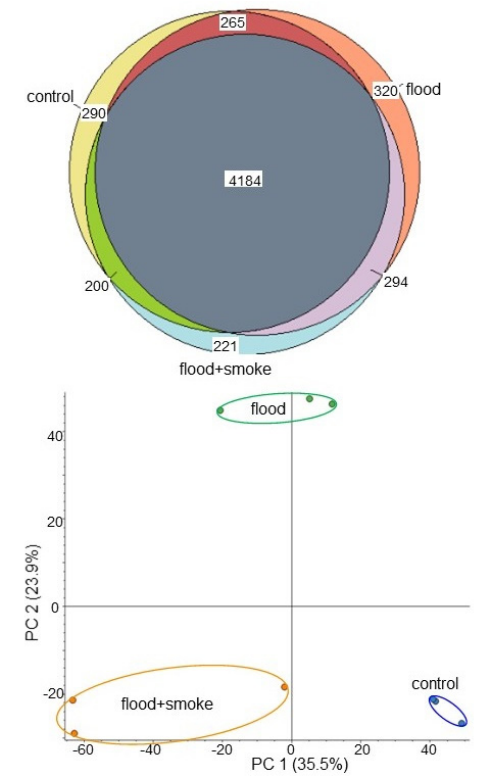
Figure 3. A Venn diagram of the proteomic results and an overview of the proteomic data of wheat based on PCA. Wheat seeds were sown and treated with or without the plant-derived smoke solution. Three-day-old wheats were exposed with or without flooding for 3 days. Wheat leaves were collected for protein extraction. Proteomic analysis was performed with 3 independent biological replicates for each treatment. The number in the Venn diagram shows the number of proteins identified by proteomic analysis. PCA was performed with Proteome Discoverer 2.2 using proteins from 9 kinds of samples.